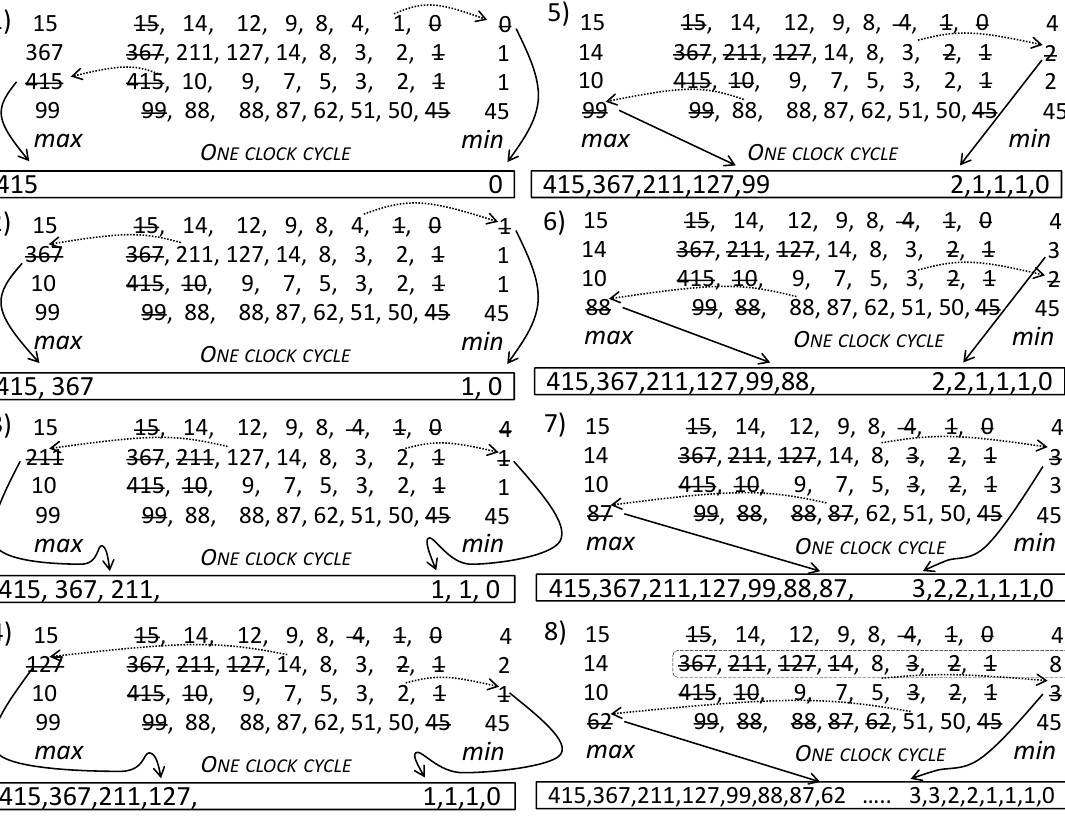
Fig. 5. The first 8 steps for merging K sorted subsets: K = 4, N 0 = N 1 = N 2 = N 3 =